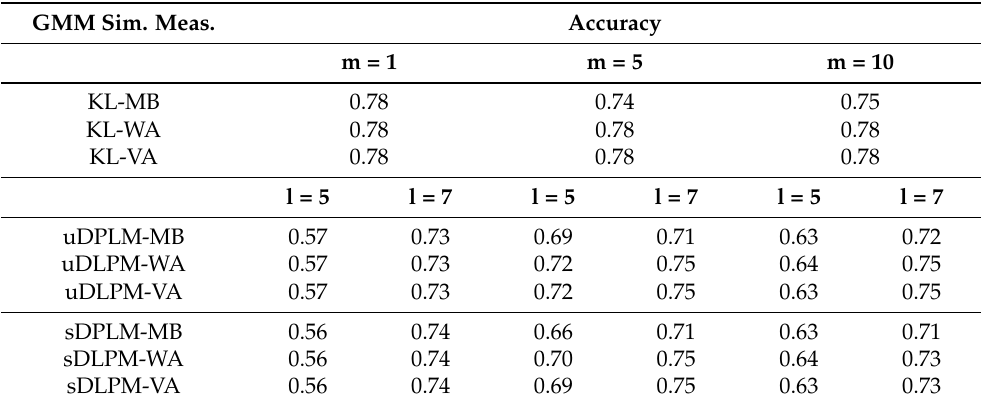
Table 2. Recognition accuracies for DPLM-based and KL-based measures on the KTH-TIPS database. GMM Sim.